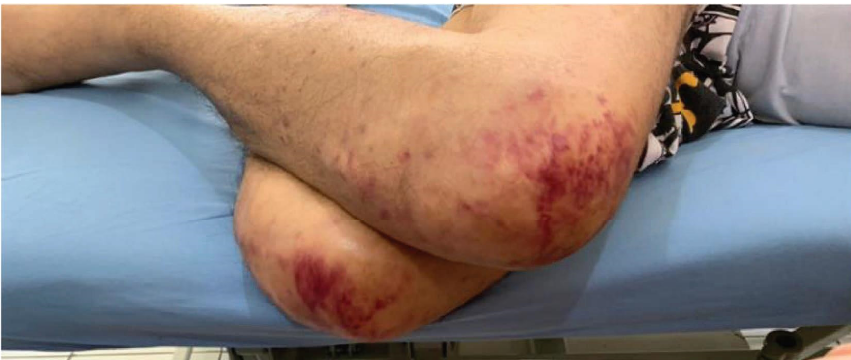
Figure 5: Large ecchymosis in the lower extremities.